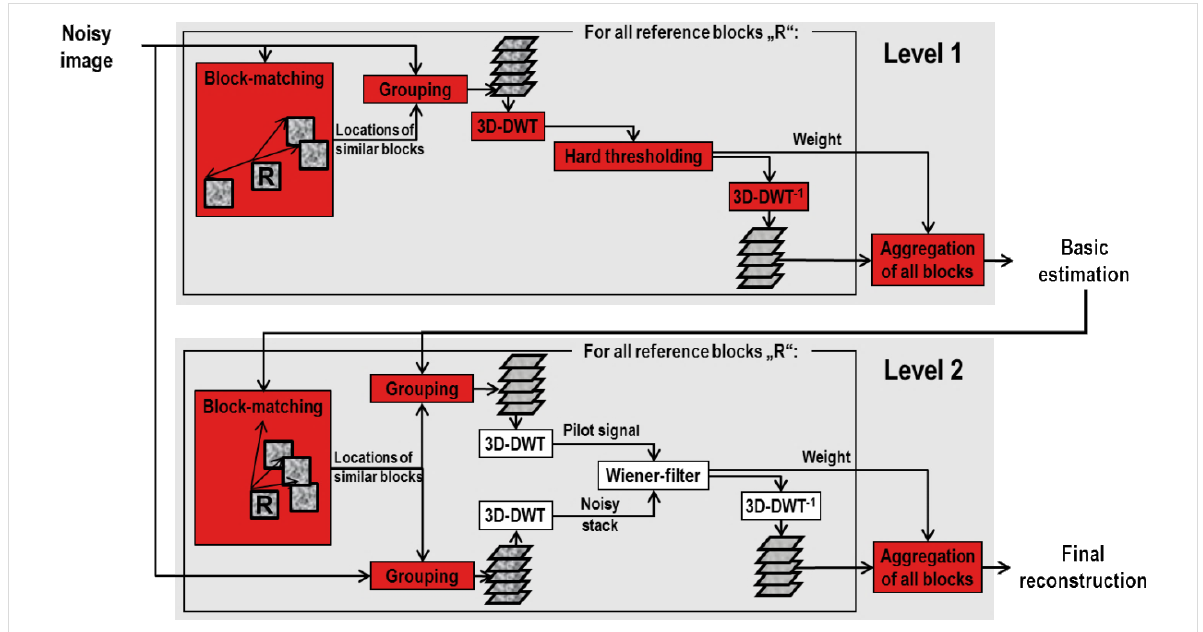
Figure 2: Flowchart of the BM3D algorithm. Red-colored steps were modified by us in order to adapt the algorithm described by Dabov et al. [15] to nanoparticle detection in mucosal tissues. DTW, discrete wavelet